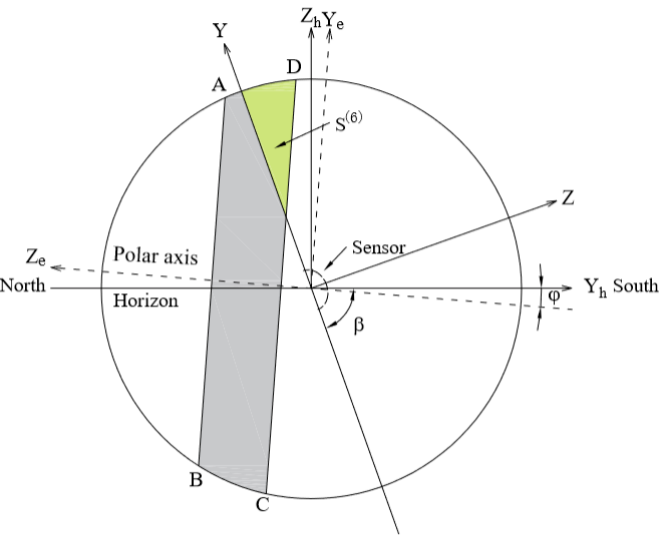
Figure 18. Schematic diagram for the calculation of S e while φ e , r ≤ π /2 and β > φ e , l + ϕ .